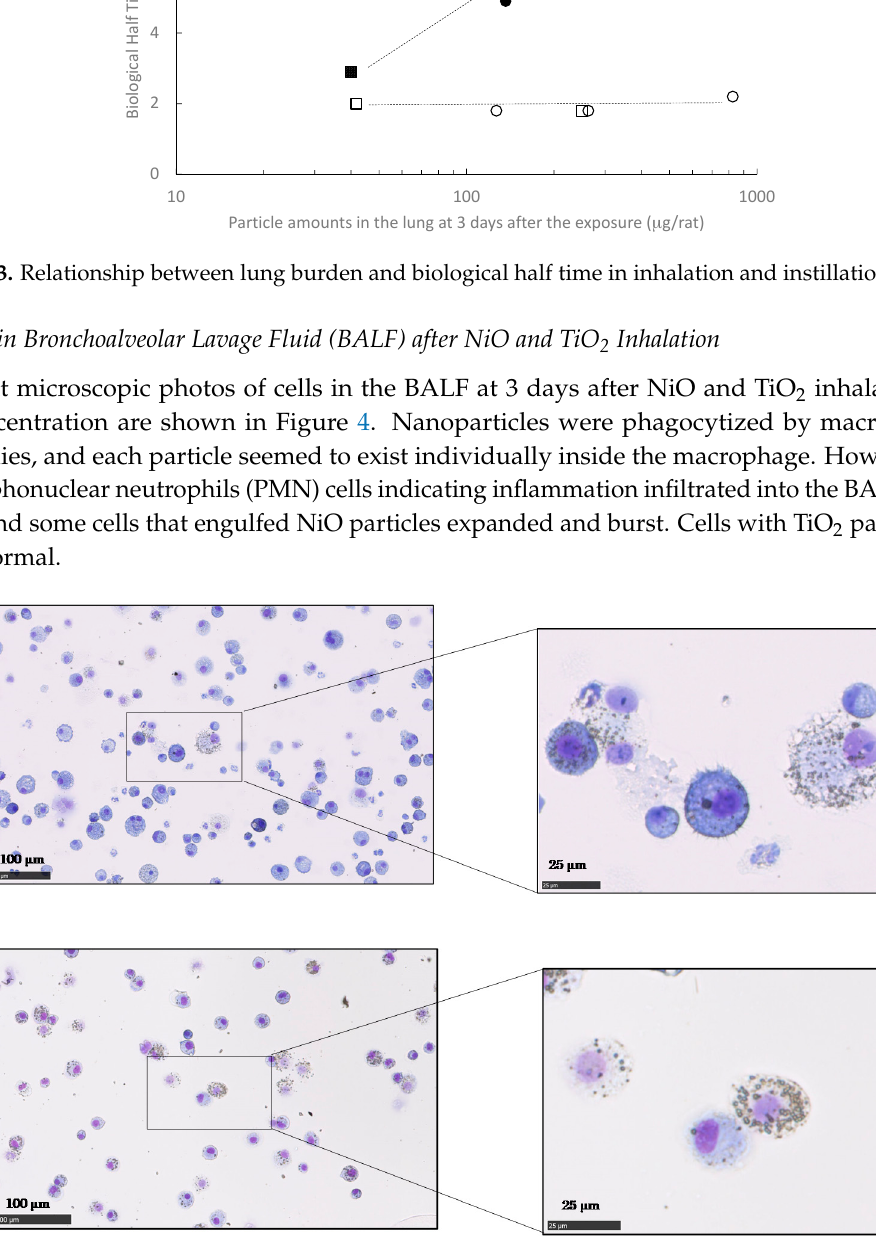
Figure 4. Cells in bronchoalveolar lavage fluid (BALF) at 3 days after the inhalation. ( A ) ② NiO-IH-H; ( B ) ⑥ TiO 2 -IH-H.